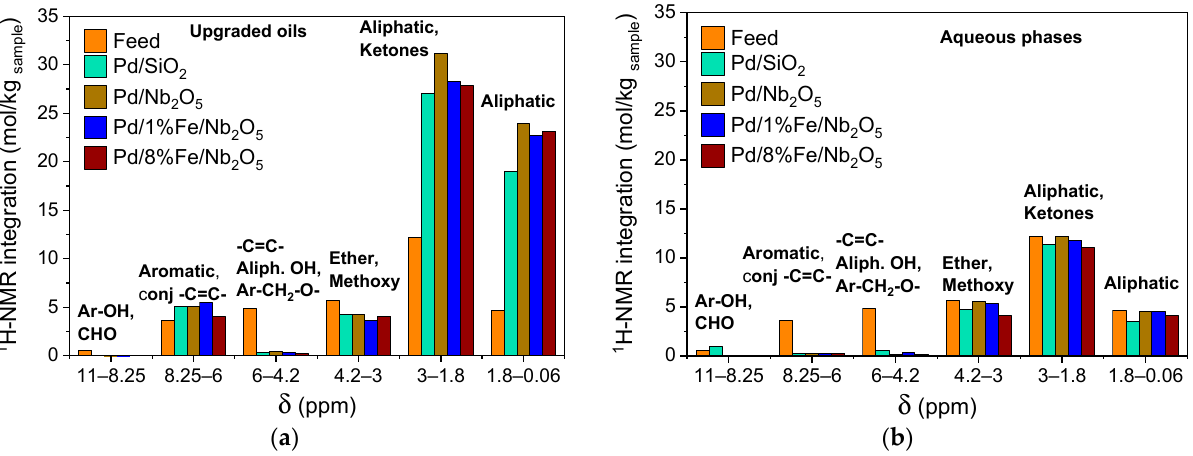
Figure 8. 1 H-NMR integration at different ranges for ( a ) the upgraded oils and ( b ) the aqueous phases.